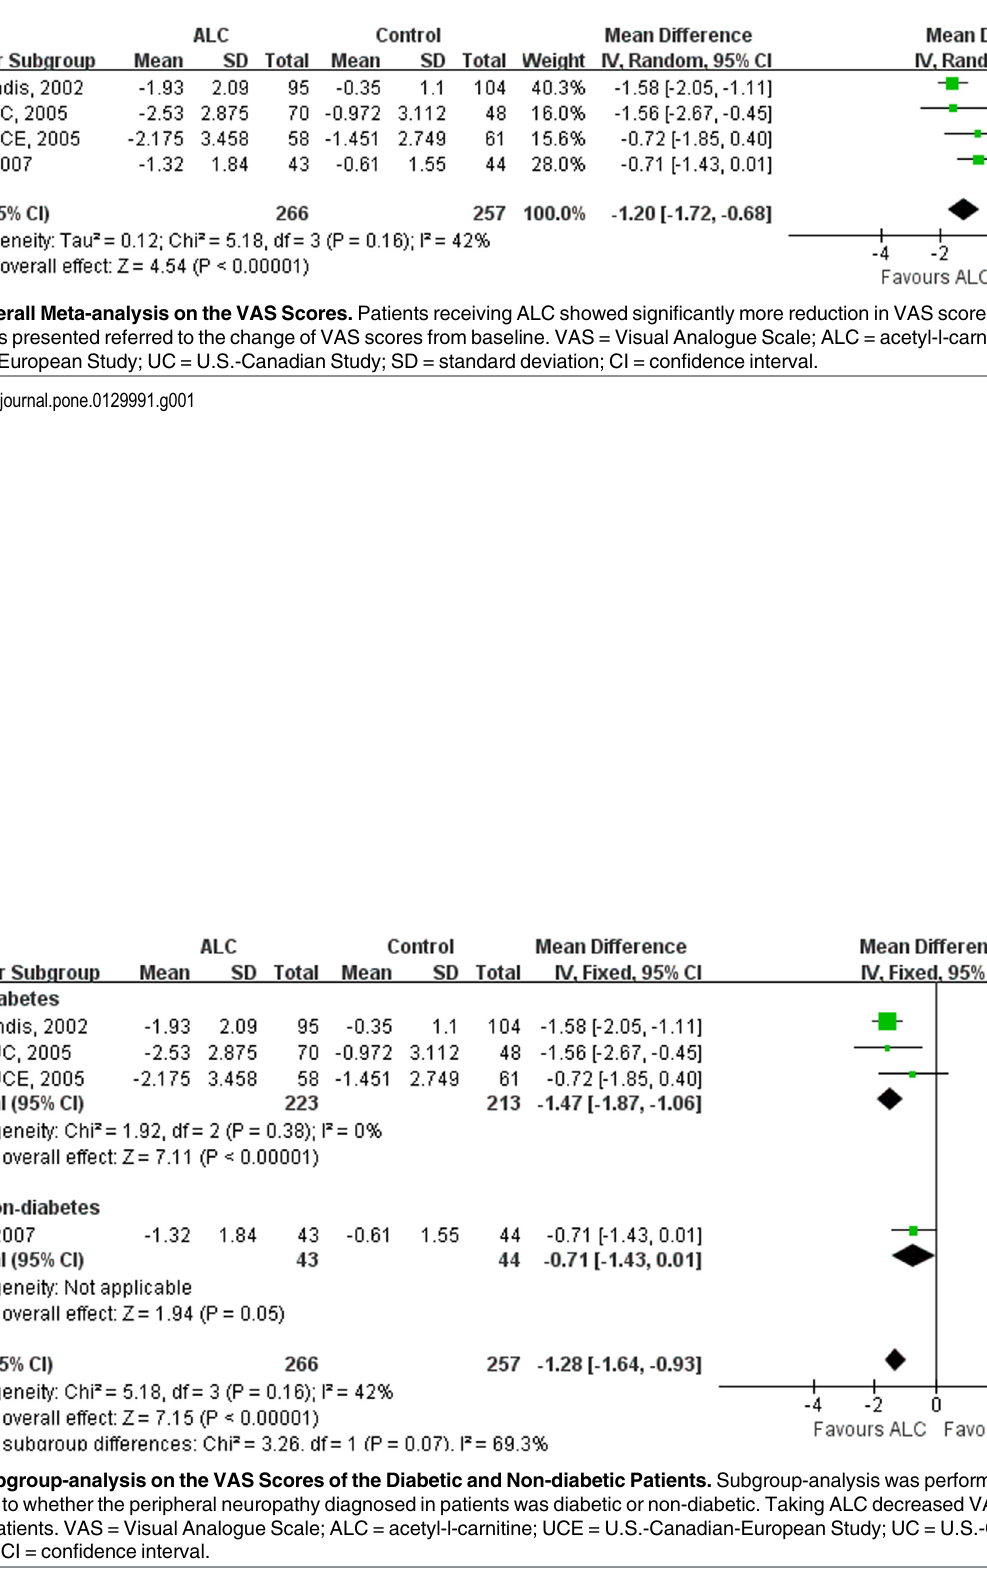
PLOS ONE | DOI:10.1371/journal.pone.0129991 June 12, 2015 2 /